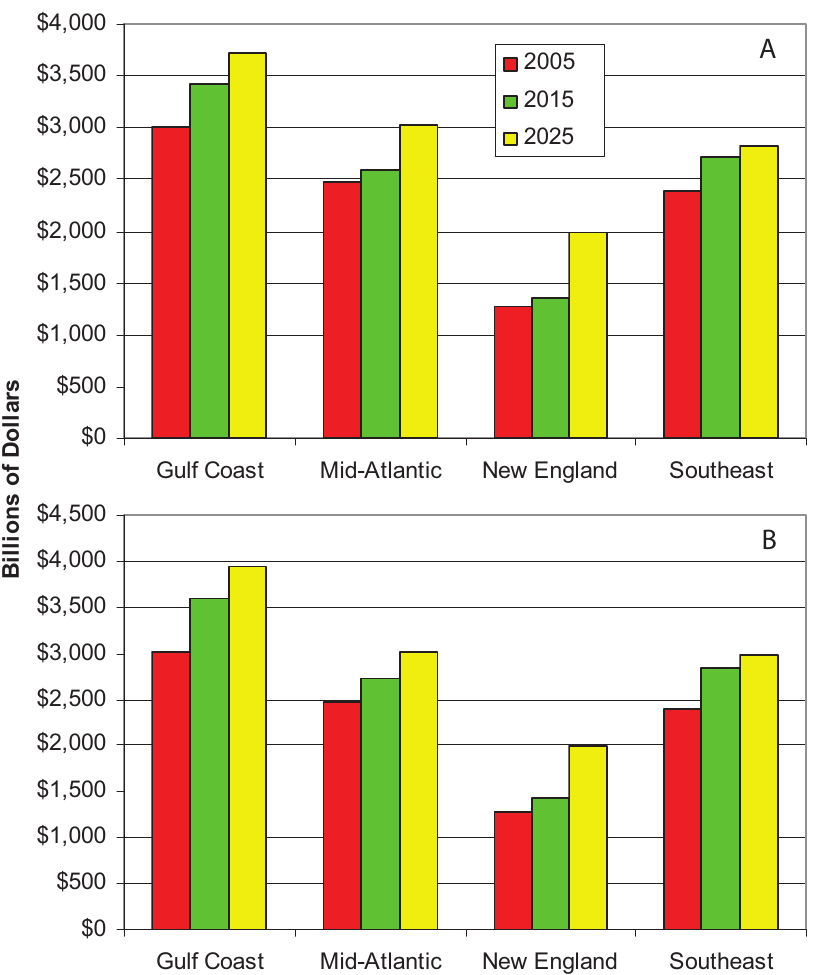
Figure A3. Value of coastal property from data, 2005–2025. ( A , B ) represent 0.5% and 1% growth, respectively (source: U.S. Census